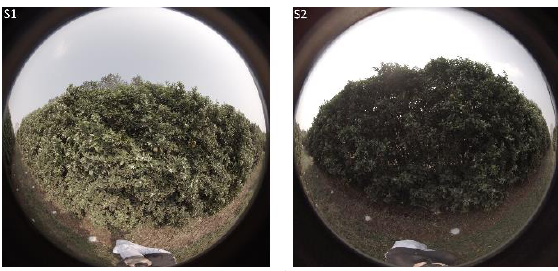
Figure 2. Fisheye images of each GoPro Fusion sensor (sensor1 – S1, sensor 2 – S2) acquired in the orange orchard.